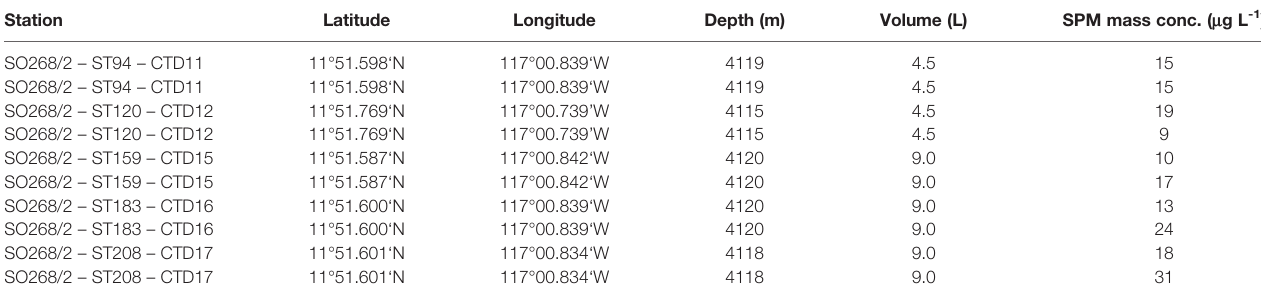
TABLE 3 | SPM mass concentration obtained from bottom water samples at fi ve CTD stations during cruise SO268.